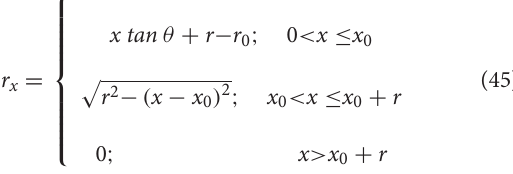
Figure 6A defines a two-dimensional coordinate system for plane A. The X-axis is coplanar to the cylinder head while Y axis is coaxial to the centerline of the cylinder. The point where X and Y axes cross is defined as the origin. The Plane C is extended in both directions to intersect with every possible plane. The intersection lines in the 3-D space are reduced to points A, B, C, D, E and O in this 2-D plane, where point A stays on line Y h p 1 , point B stays on line Y h p 2 , point C stays = − = − on line Y 0, point D stays on line X R cyl and point O = =